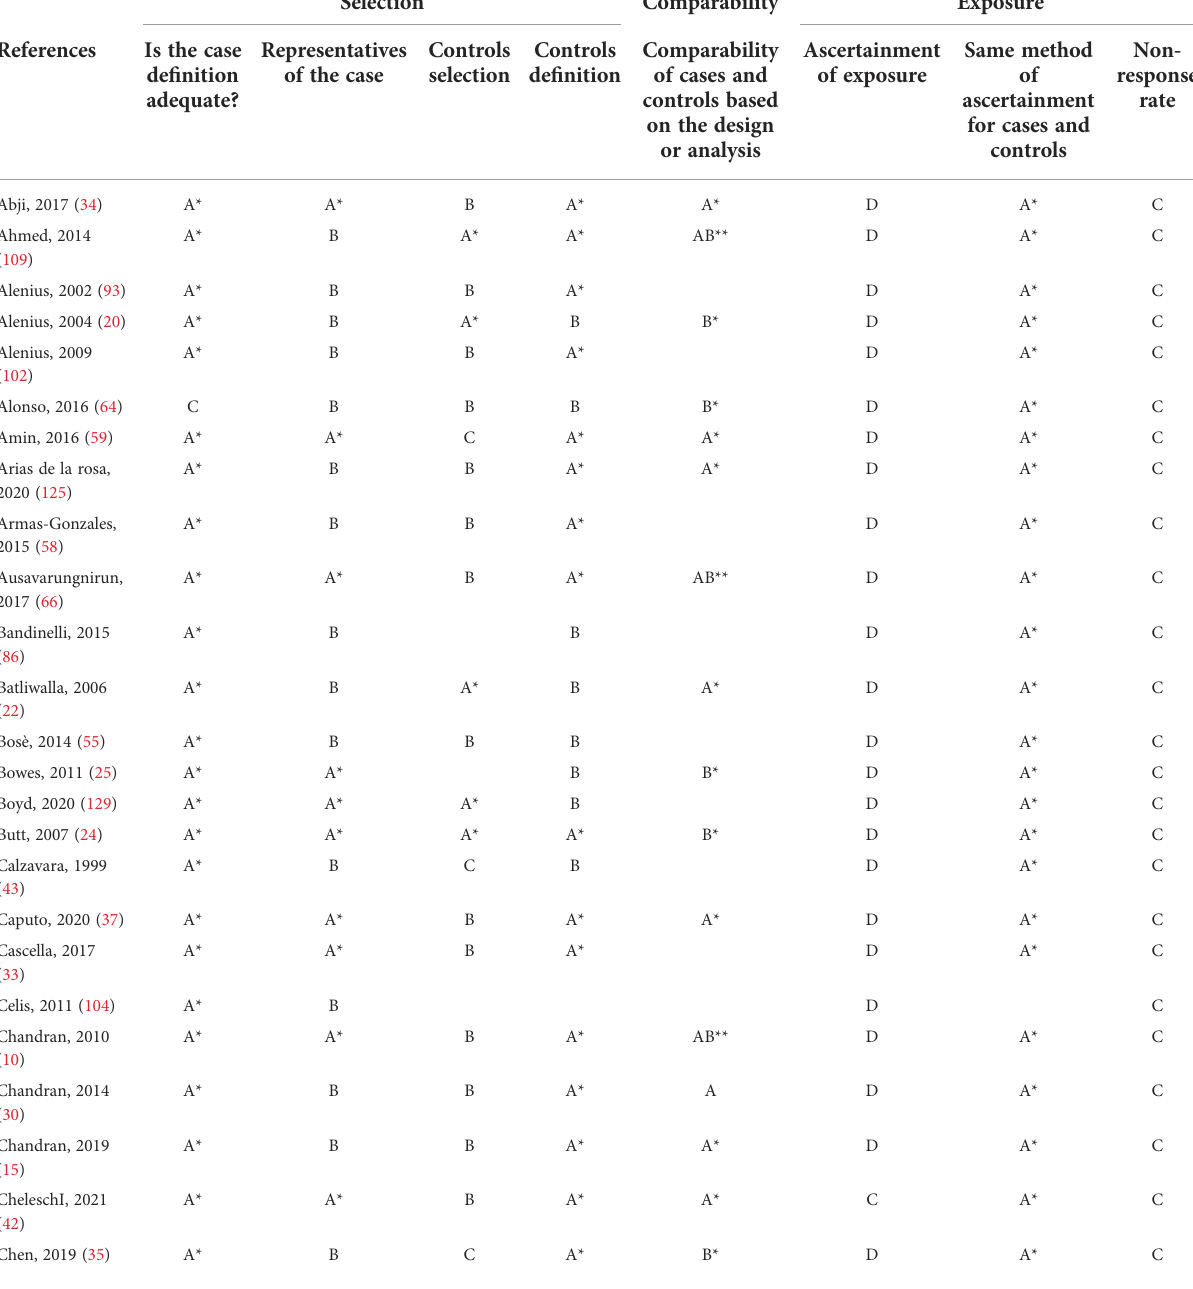
TABLE 3 Assessment of bias risk using NOS scale for case-control